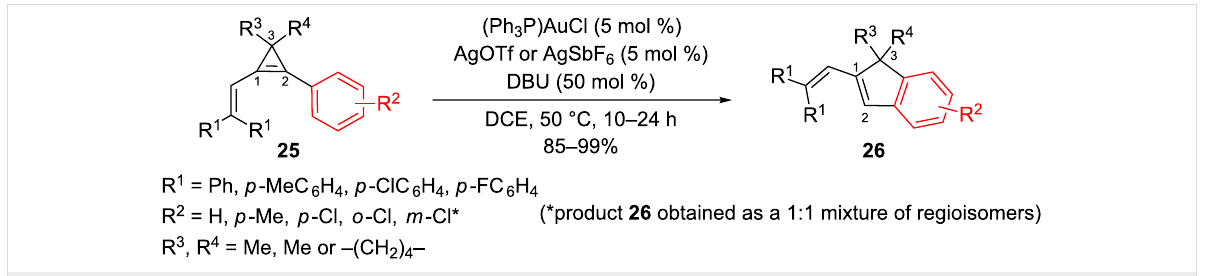
Scheme 11: Mechanism of the Lewis acid-catalyzed reactions of cyclopropene 18 .